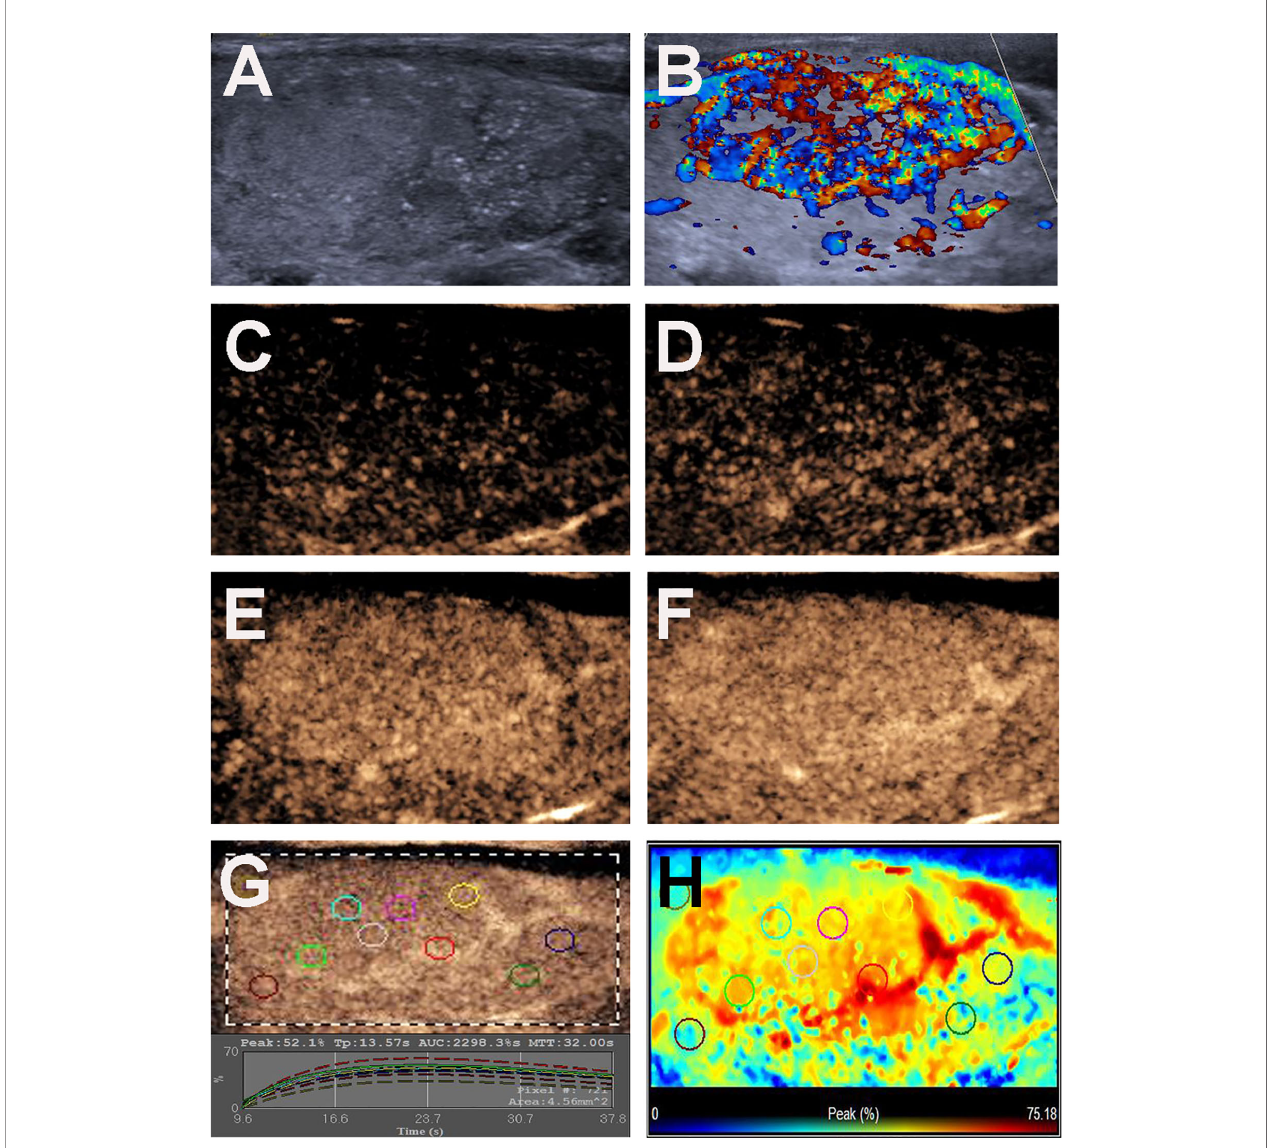
FIGURE 3 | Conventional US and CEUS images of a 31-y-old female PTC patient with Hashimoto ’ s thyroiditis of the right thyroid lobe with CLNM. (A) B-mode US image revealing a 35.0-mm solid thyroid nodule with iso-echogenicity, ill-de fi ned margins and microcalci fi cation. (B) Doppler image revealing abundant peripheral and internal vascularity. (C – F) CEUS images revealing a centripetal homogeneous hyperenhancement with an incomplete ring of thyroid nodule from the periphery to the center, at (C) 11s (wash-in), (D) 12s, (E) 14s and (F) 17s (time to peak). (G) TICs of the thyroid nodule and peripheral thyroid parenchyma with different ROIs (different color circles). (H) Parametric color map indicating the PI values for the center of nodule was lower than that of the periphery of nodule, but higher than that of adjacent thyroid